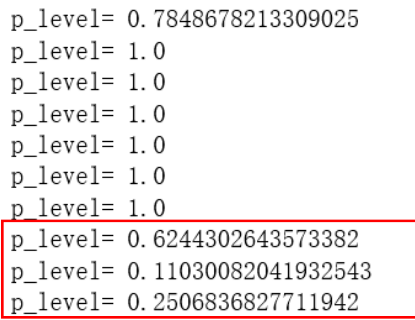
Figure A16. Significance level of variables.